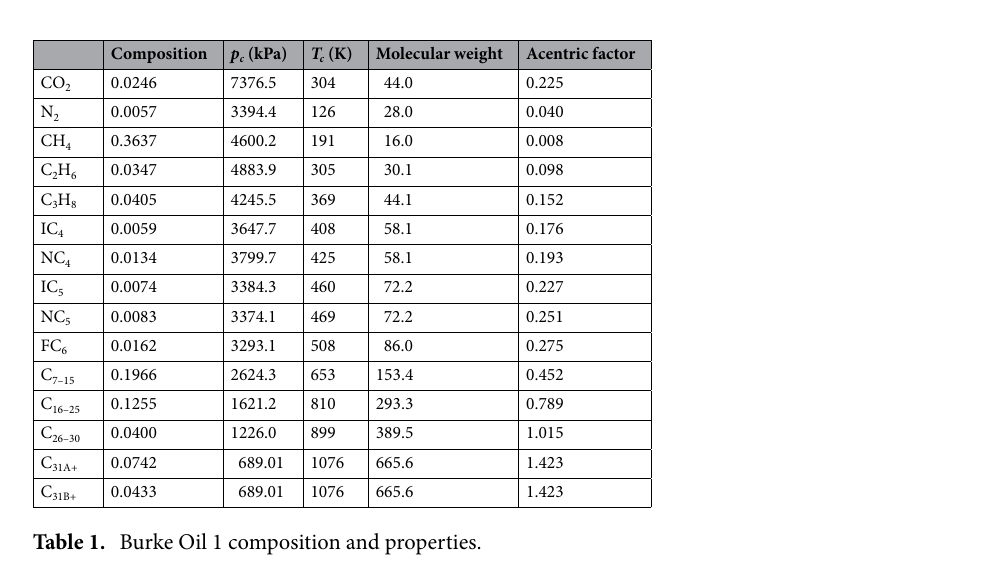
Figure 1. Water and oil relative permeability curves 11 .